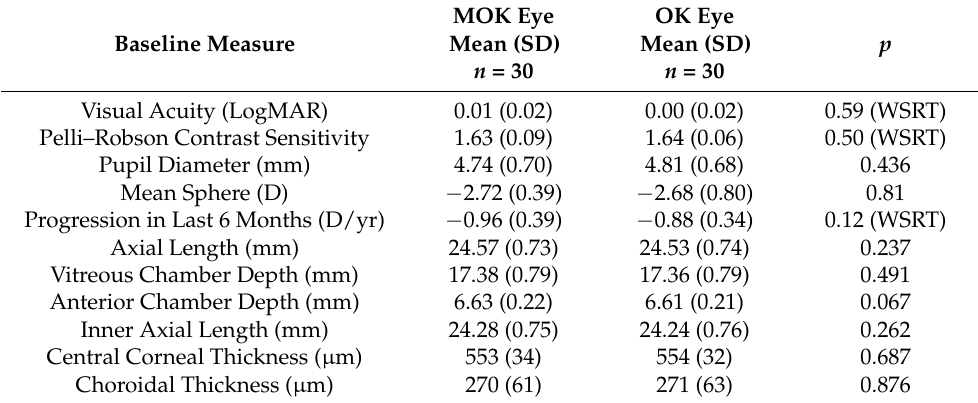
Table 1. Baseline measures (mean and standard deviation) of visual acuity, contrast sensitivity, photopic pupil diameter, refraction, myopia progression, and ocular biometry in eyes assigned to wear MOK lenses compared to those assigned to wear conventional orthokeratology (OK) lenses. Measures between eyes were compared with a paired t-test or Wilcoxon signed-rank test (WSRT). MOK Baseline Measure